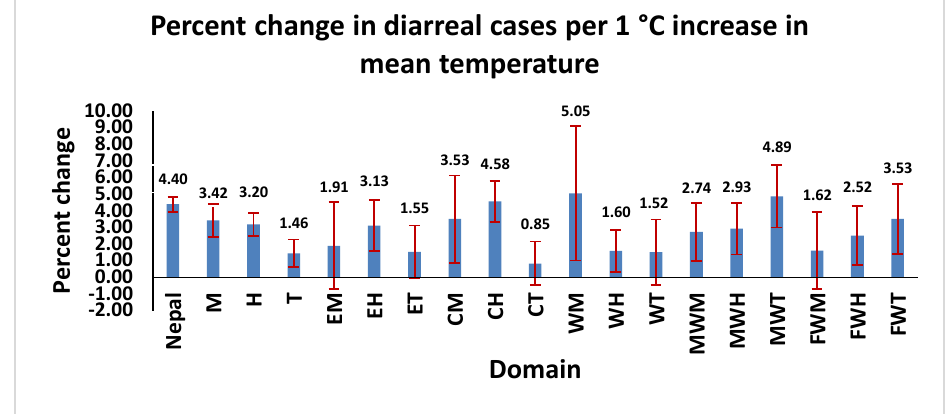
Figure 4. Percentage increase in childhood diarrheal cases per 1 °C increase in mean temperature per eco-development region, from July 2002 to June 2014. (Note: The projections were based on coefficients from the negative binomial time-series GLMs. The vertical lines in the figures represent the 95% confidence interval (CI)).